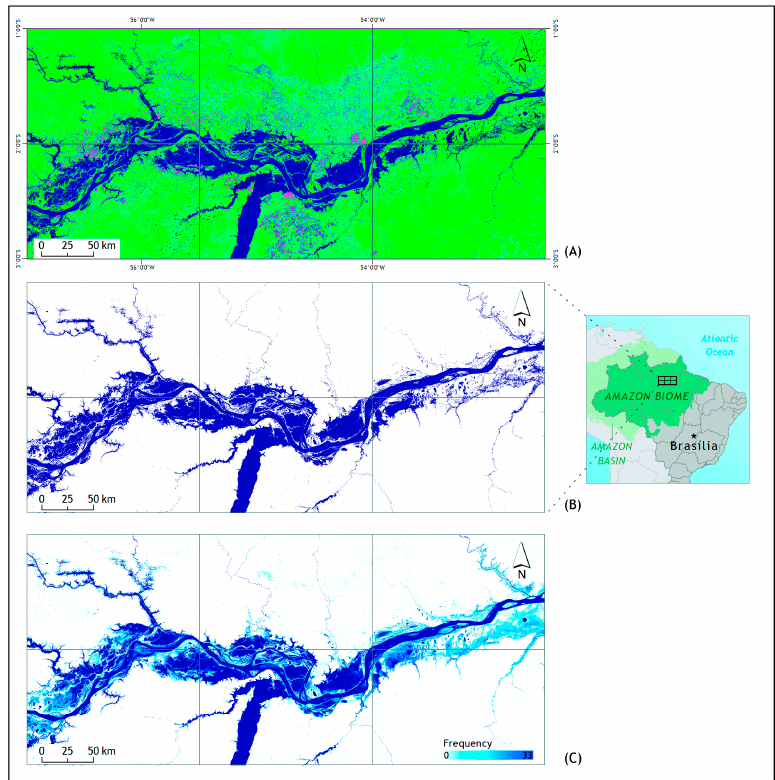
Figure 3. Example of Spectral Mixture Analysis (SMA) results for a portion of the Amazonas River and Tapajós tributary. In ( A ), a color composite obtained by combining fraction images of Soil (Red), Green Vegetation (Green) and Shade (Blue). In ( B ), the water classification based on the surface water sub-pixel classifier (SWSC) and in ( C ) the water frequency map over 33 years. Light blue areas adjacent to dark blue ones are likely to represent land areas susceptible to flooding, and bright blue areas can also designate areas that had the fewer cloud-free satellite observation such as in the left side of the Figure 3C.